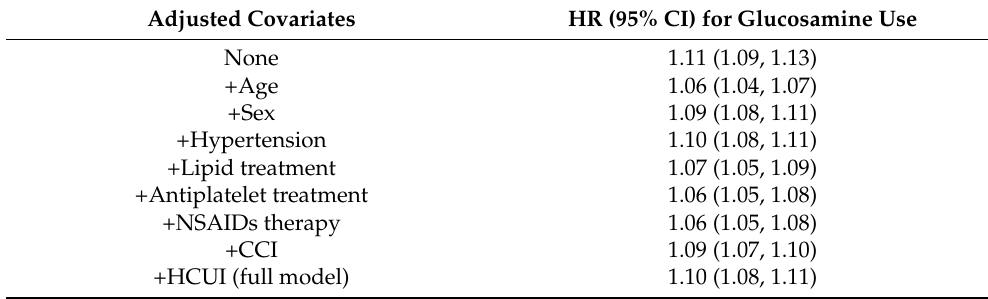
Table A1. Model adjustment of association between glucosamine use with cardiovascular disease